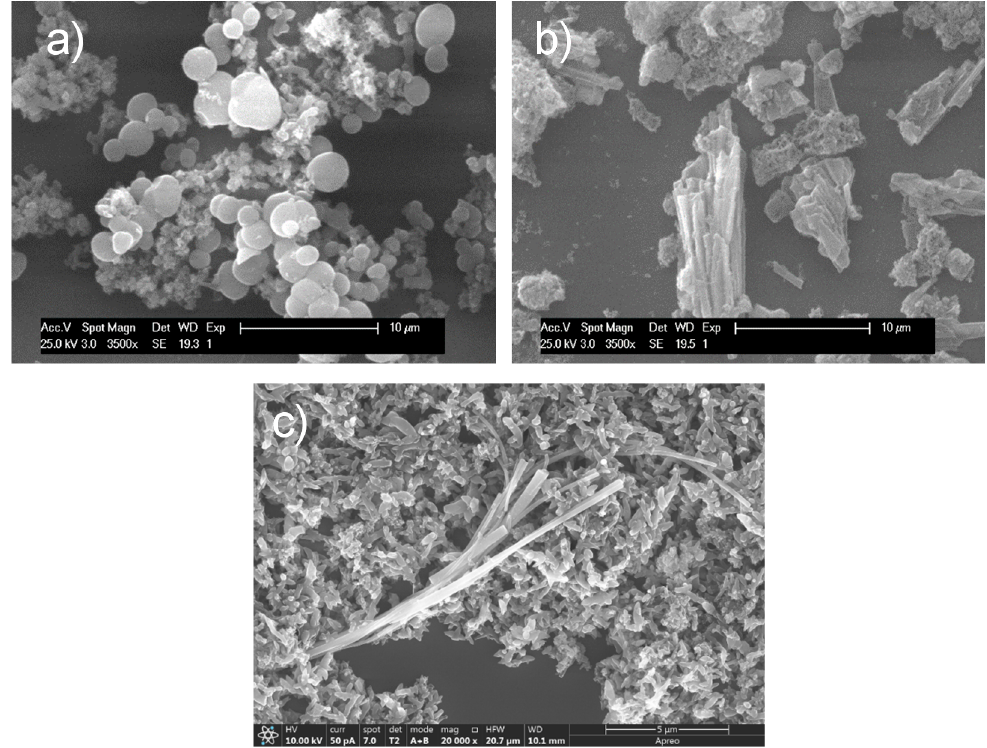
Figure 4. Insoluble HCN-derived polymers obtained using different synthetic aqueous conditions: ( a ) NH 4 CN (1 M), 80 °C, 96 h; ( b ) DAMN (0.25 M), 80 °C, 48 h; ( c ) NH 4 CN (1 M), 180 °C, 15 min using a microwave reactor.